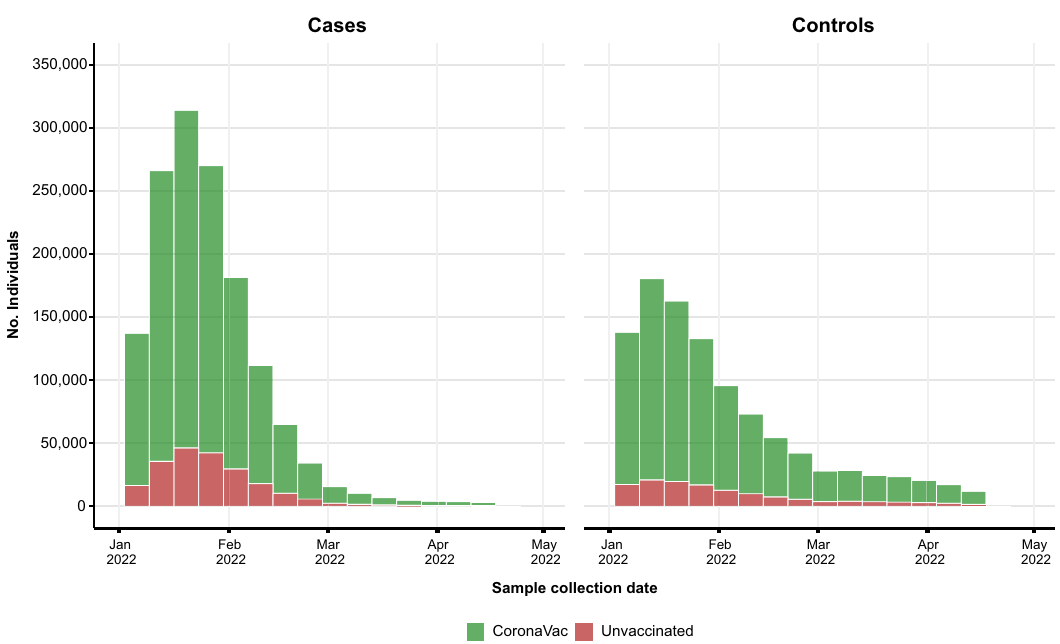
Fig. 2 Number of cases and controls, by week, during the study period, strati fi ed by vaccination status. CoronaVac vaccinees refer to individuals with at least one dose of